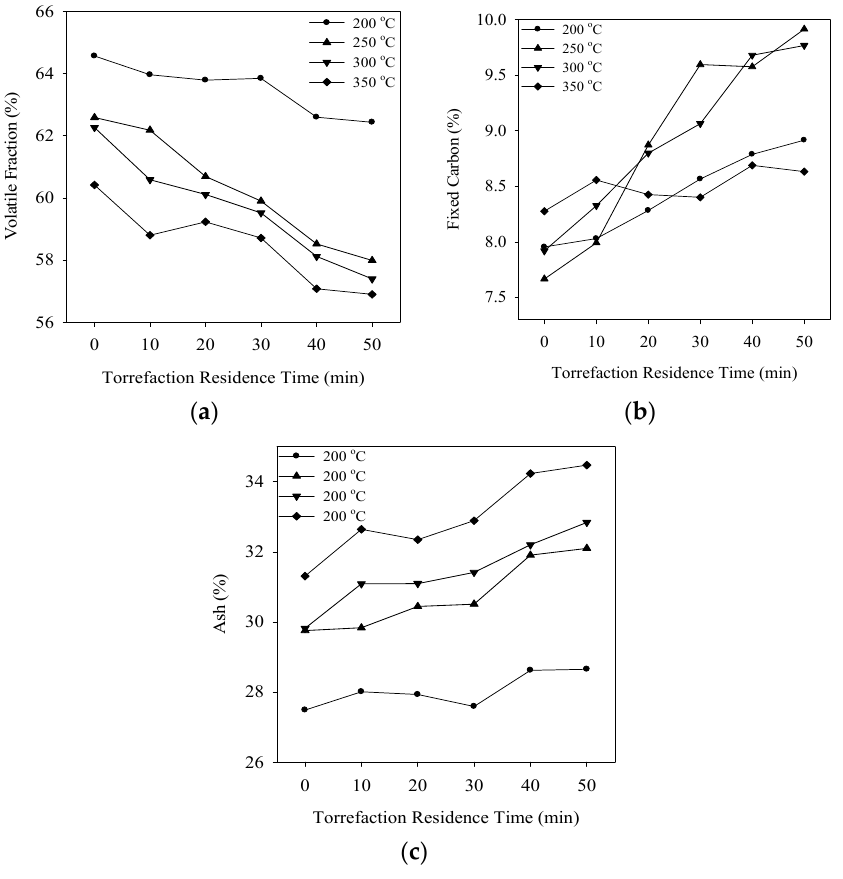
Figure 5. ( a ) Volatile fraction (%); ( b ) fixed carbon (%); and ( c ) ash (%) as a function of the torrefaction residence time.